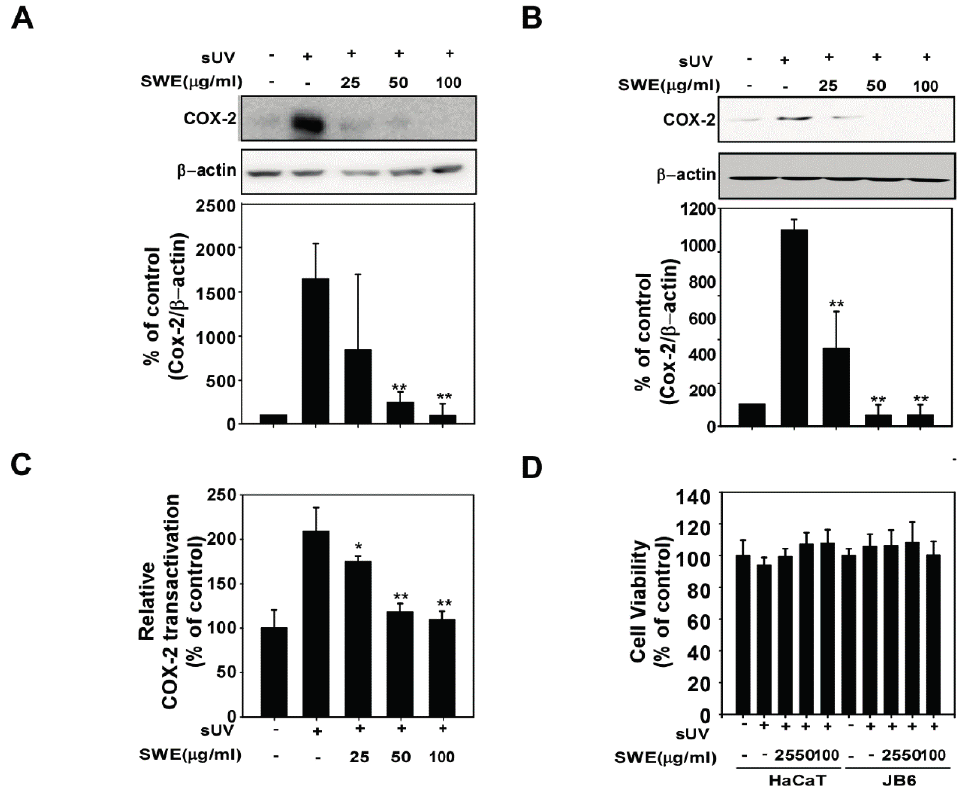
Figure 1. Effects of Silkworm Thorn stem extract (SWE) on solar ultraviolet (sUV)-induced cyclooxygenase (COX)-2 expression in JB6 and HaCaT cells. ( A , B ) SWE inhibits sUV-induced COX-2 expression in ( A ) JB6 and ( B ) HaCaT cells. The cells were treated with SWE at the concentrations indicated (0, 25, 50, or 100 µg/mL) for 1 h before exposure to 90 kJ/m 2 sUV and harvested 4 h later. COX-2 and β -actin (control) expression levels were assessed by Western blotting. COX-2 expression was quantified using the Image J software program; ( C ) SWE suppresses sUV-induced cox-2 promoter transactivation activity. JB6 cells were stably transfected with COX-2 luciferase reporter plasmids and treated with SWE at the indicated concentrations (0, 25, 50, or 100 µg/mL) for 1 h before exposure